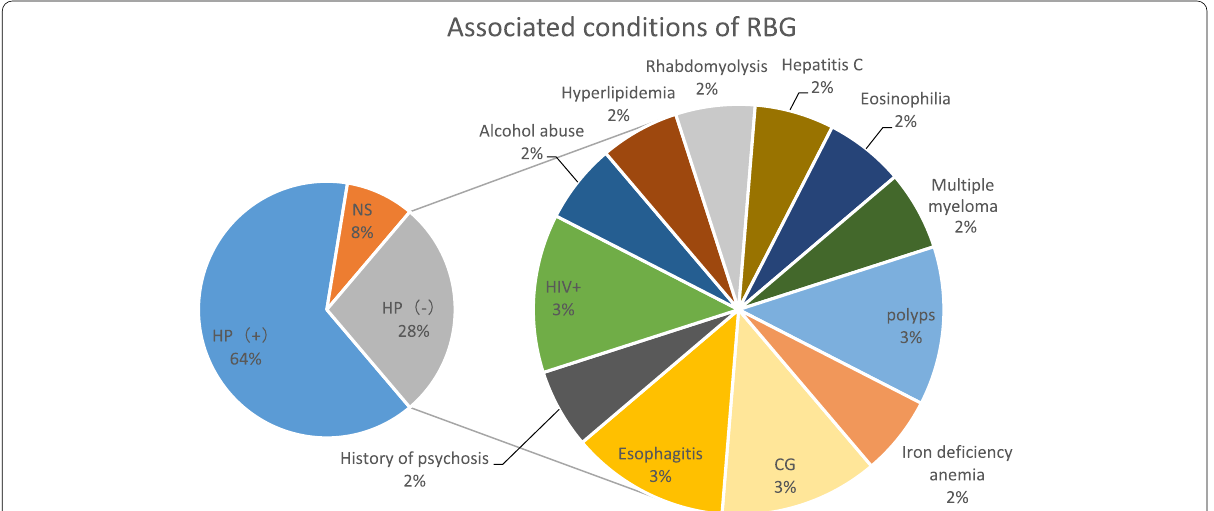
Fig. 7 Associated conditions in patients with Helicobacter pylori-negative RBG according to the available